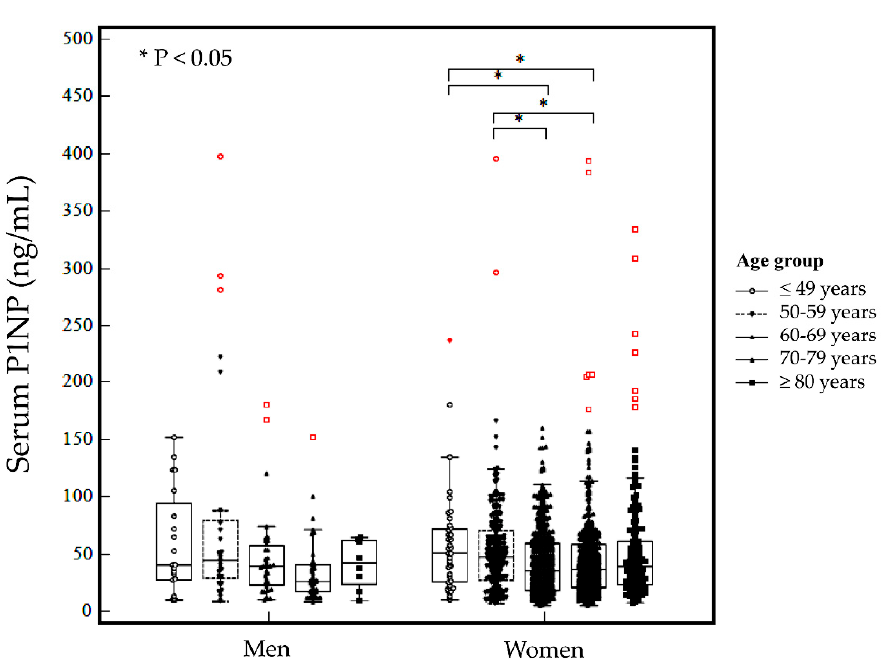
Figure 1. Baseline serum P1NP level by sex and age group. The middle line represents the median, and the central box represents values from the lower to upper quartile (25 to 75th percentiles). Red color represents a value larger than the upper quartile plus 3 times the interquartile range.